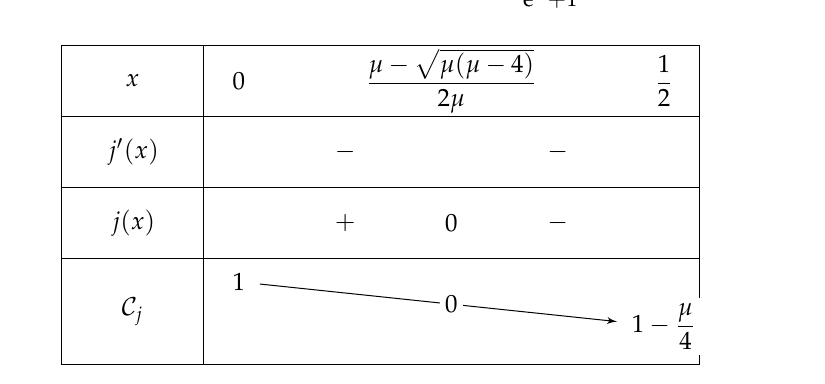
Figure 6. Variation of H when a (cid:54)